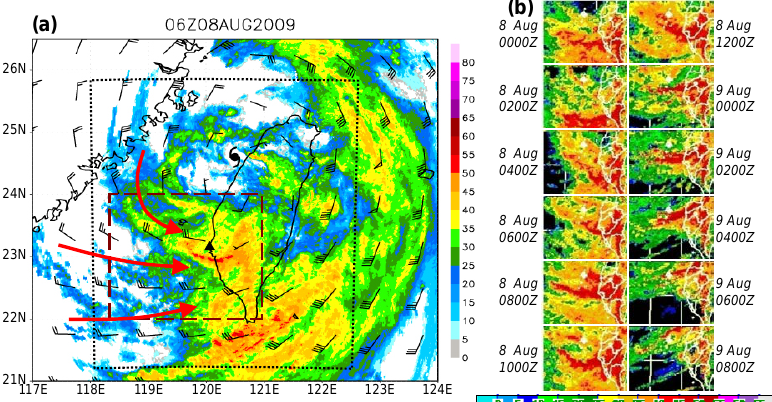
Figure 3. (a) The composite of radar VMI reflectivity (dBZ, scale on the right) near Taiwan overlaid with the ECMWF-YOTC 850 hPa horizontal winds (ms − 1 , full (half) barb = 10 (5)ms − 1 ) at 06:00UTC, 8 August 2009. The TC center is marked by the typhoon symbol, and the 1km domain used in this study is also plotted (black dotted region). The triangle marks the location of Chigu radar. (b) Radar VMI reflectivity composites (dBZ, scale at bottom) over the brown dashed box in (a) every 2h over 00:00–12:00UTC, 8 August and 00:00– 08:00UTC, 9 August 2009.